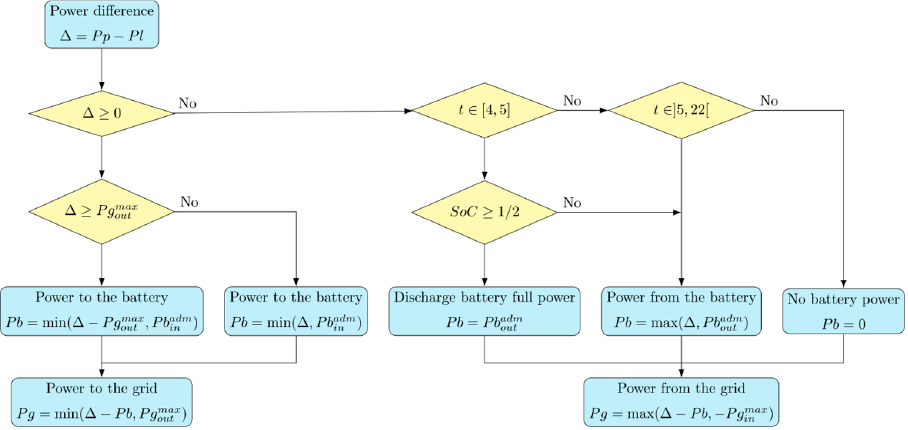
Figure 9. Flowchart of RBC2.